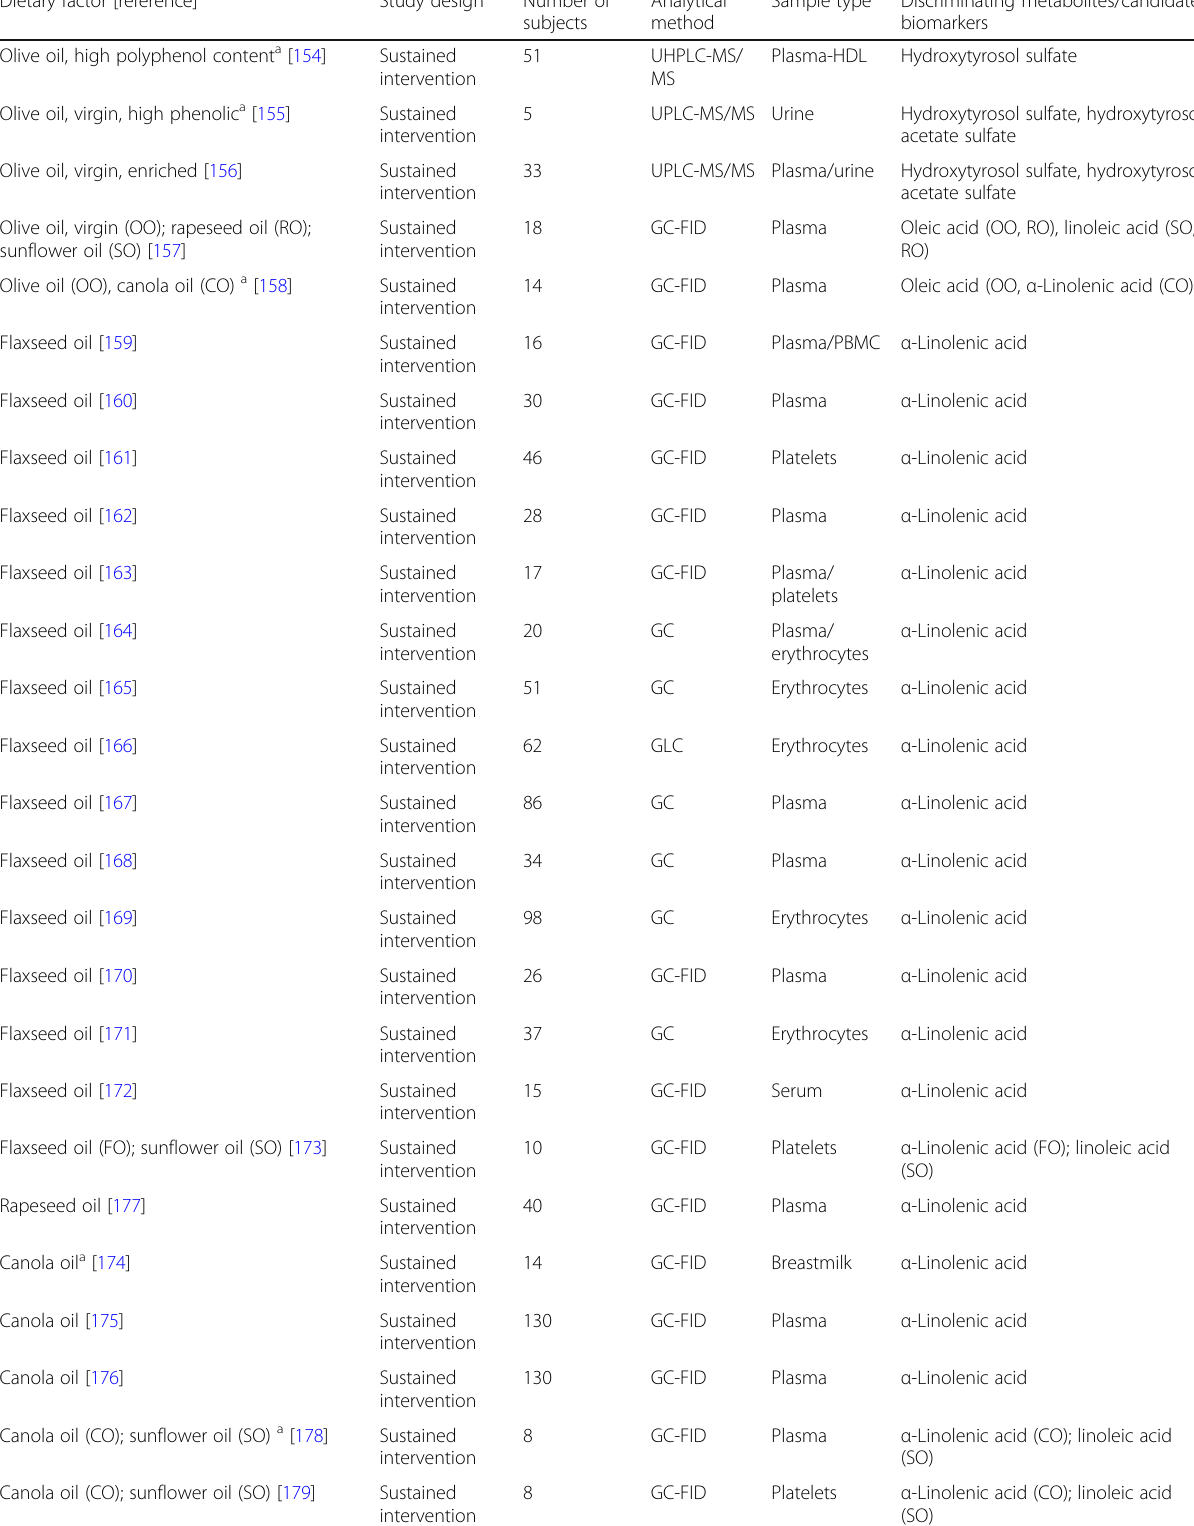
Table 3 Studies reporting associations between consumption and potential candidate food intake biomarkers for vegetable oils (Continued) Dietary factor